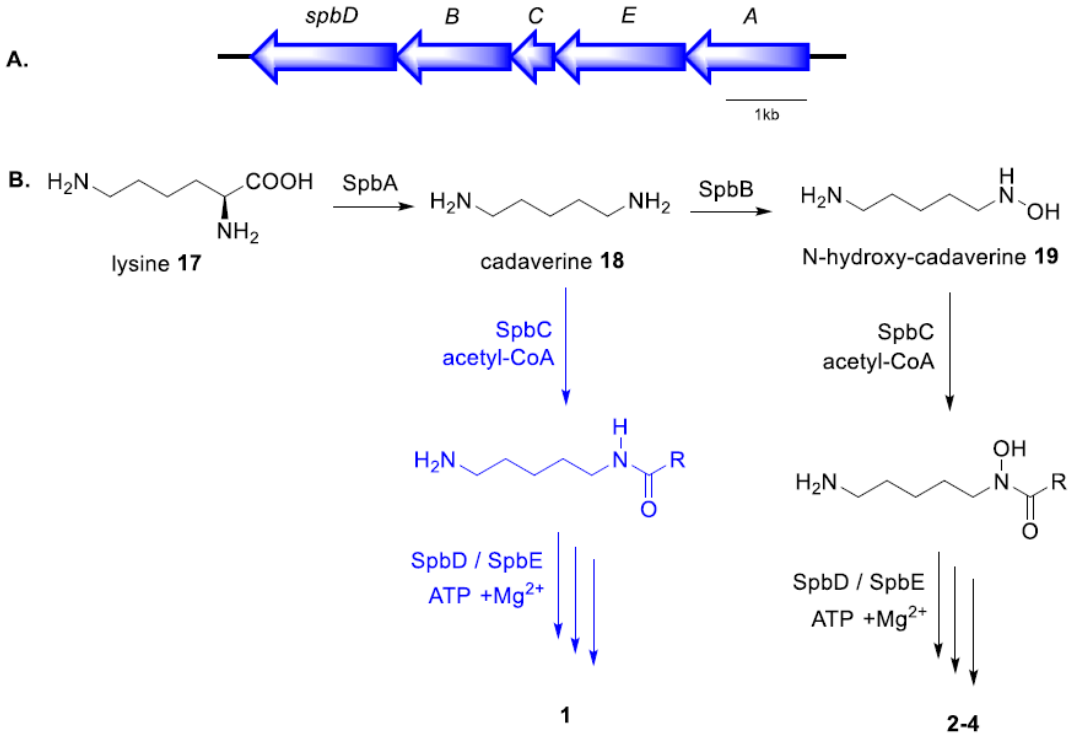
Figure 3. ( A ) Speibonoxamine ( spb ) biosynthetic gene cluster in the K. speibonae strain SK5; ( B ) proposed biosynthetic pathway of 1 – 4. Table 1. Deduced functions of open reading frames (ORFs) in spb biosynthetic gene cluster (BGC).